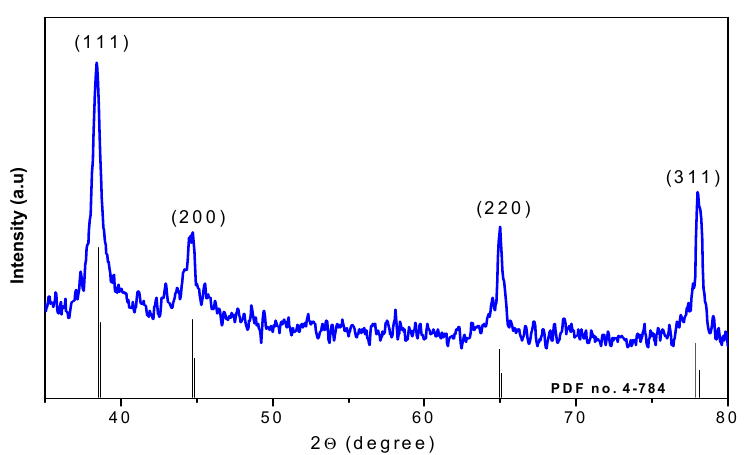
re fl ection and was found to be 19 nm. reflection and was found to be 19 nm.